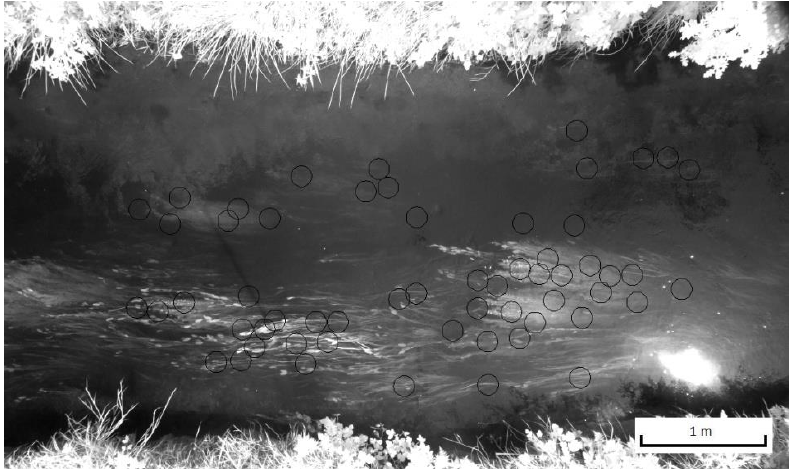
Figure 11. NIR reflection at water surface (light haze in top half of the reach); Band NIR(R72), site